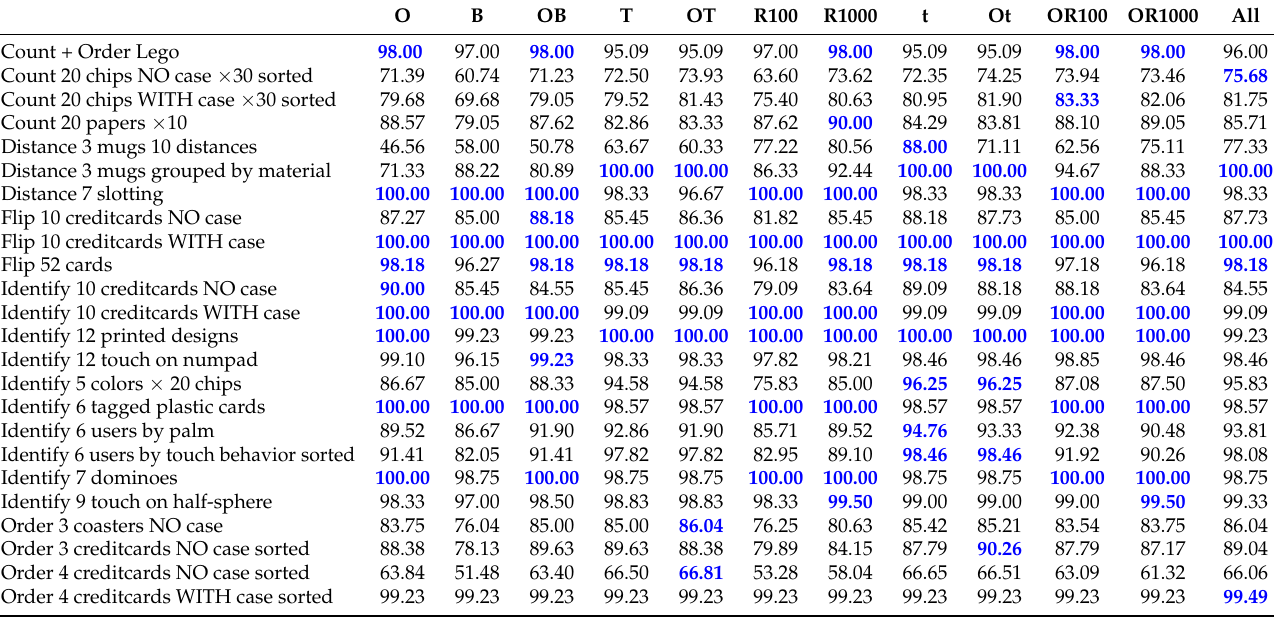
Table A3. Results for classifier SVM-G with different feature